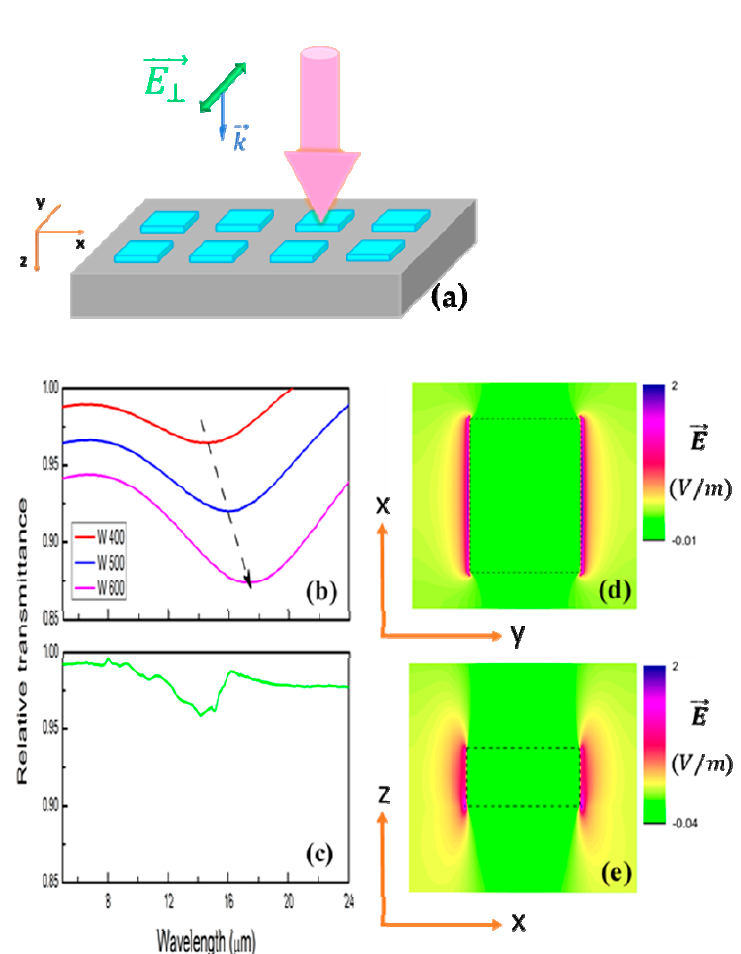
Figure 6. Schematic illustration of polarized infrared light with electric field vector parallel to the longer axis of nanostrips ( E ⊥ ) ( a ). Simulation ( b ) and FTIR relative transmittance ( c ) of nanostrips with ( E ⊥ ) polarized incident light. Widths of nanostrips (W) in simulation were set at 400, 500, and 600 nm, corresponding to red, blue, and pink curves (b). Measured spectrum was plotted in green line (L × W ~ 700 nm × 450 nm) ( c ). Electric field distribution along x-y and x-z planes of strips ( d , e ).